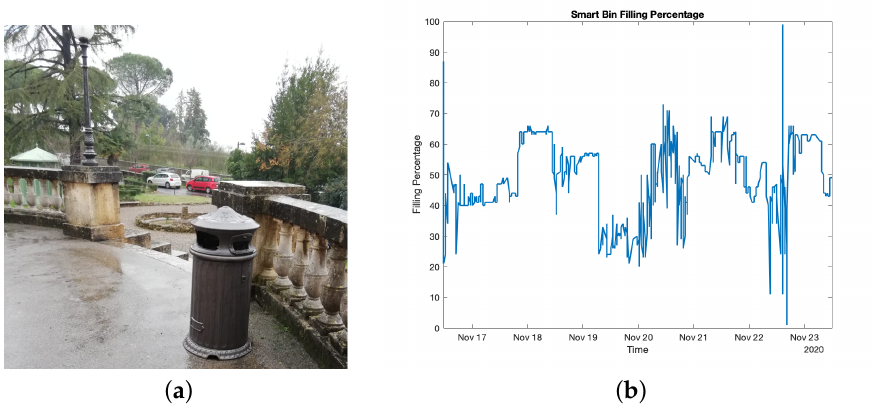
Figure 9. Smart bin test setup: ( a ) smart bin outdoor installed; ( b ) filling level percentage trend throughout the test